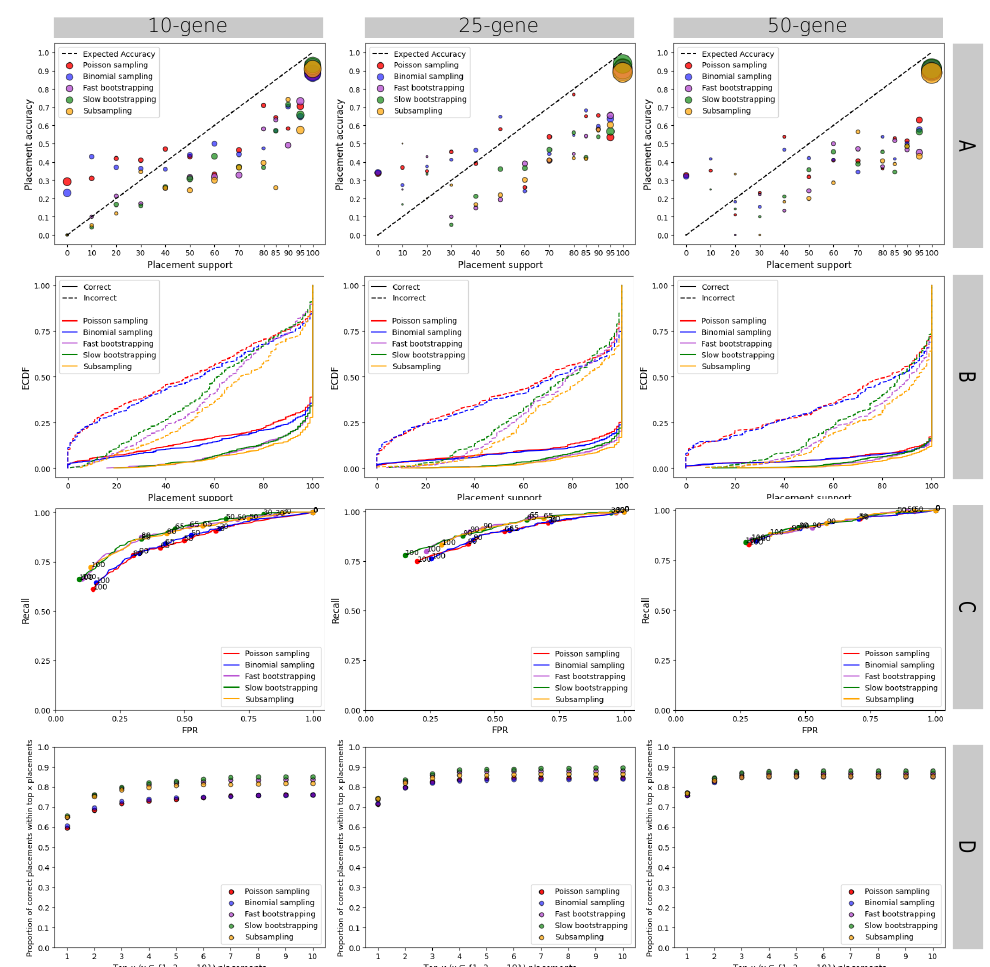
Figure A1. Results for the WOL multi-gene dataset. We show the results obtained from the concate- nation of the best 10, 25, and 50 genes. Results of four different analyses as in Figure 1 are shown here. ( A ) Relationship between support calculations and frequency of correct placements. Each figure shows the aggregated results on 1000 queries. ( B ) Empirical cumulative distribution function (ECDF) plot of the support values, showing the percentage of the correct/incorrect placements (shown in the y -axis) at or below specified placement support levels (in the x -axis). ( C ) ROC curves, built using a range of 0–100 support thresholds. Selected thresholds are shown on the graph. ( D ) We show how often the correct placement is among the top x placements (in terms of support values) for different values of x . Here, unlike our other analyses, we used the “best” subset of the “WOL-random” dataset in [16] that was built identically to the WoL-best, except that it includes a different set of 1000 backbone and 1000 query